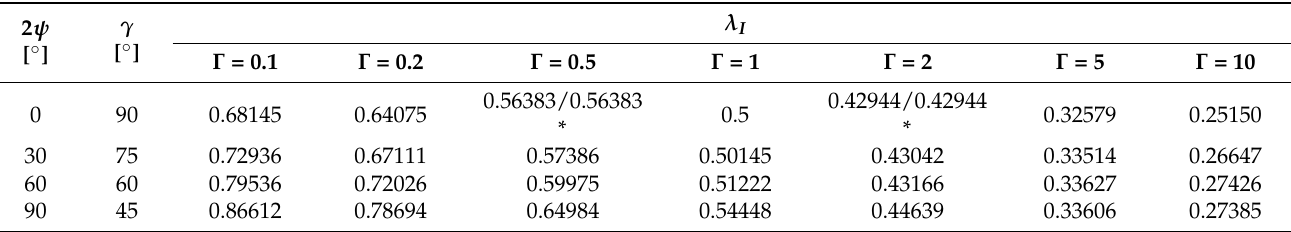
Table 1. The eigenvalues λ I (Mode